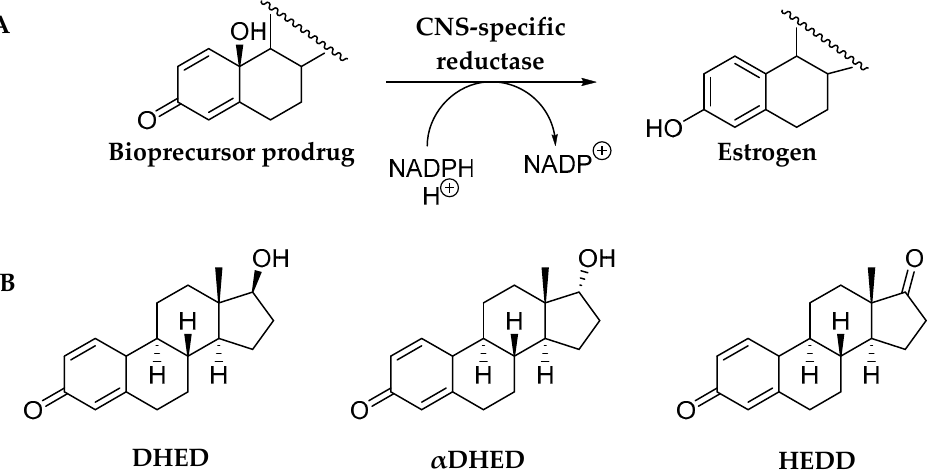
Figure 3. ( A ) Schematic illustration of CNS-specific reductive bioactivation of bioprecursor prodrugs shown in panel B by an NADPH-dependent short-chain dehydrogenase to the corresponding estrogen (E2, α E2 or E1). ( B ) Chemical structures of bioprecursor prodrugs of estrogens: 10 β ,17 β -dihydroxyestra-1,4-dien-3-one (DHED) for E2; 10 β ,17 α -dihydroxyestra-1,4-dien-3-one ( α DHED) for α E2, and 10 β -hydroxyestra-1,4-dien-3,17-dione (HEDD) for E1.